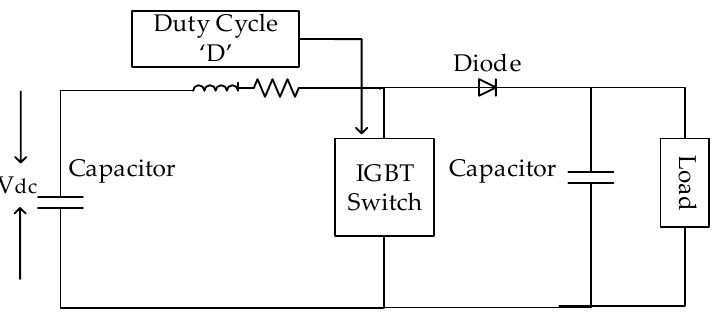
Figure 15. Block diagram of grid-connected PV system. V pv and I pv from the PV array are sent to the MPPT controller for tracking of MPP through controlling of the duty cycle. MPPT algorithm [19] tracks MPP by adjusting the operating voltage to track MPP. The voltage changes in the same direction if power increases, and voltage variation reverses its direction if power decreases. The algorithm of perturb and observe (P&O) [18] is easy to